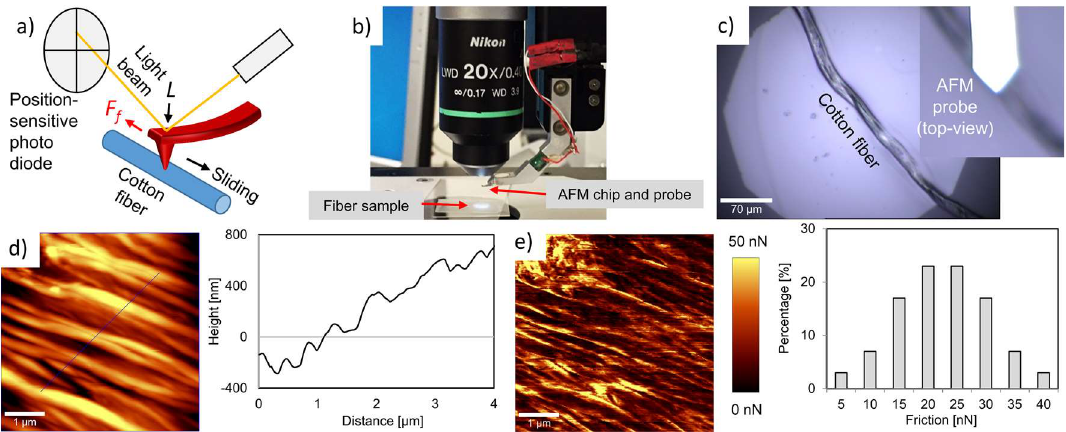
Figure 5. ( a ) Schematic of an atomic force microscope (AFM) probe as it raster scans the fiber surface; ( b ) AFM chip mounted on AFM head which is coupled with optical microscope system; ( c ) cotton fiber and AFM cantilever viewed from optical microscope; ( d ) typical topography image of cotton fiber surface. The plot show profile of fiber surface along the line; ( e ) corresponding friction image of the fiber surface. Plot shows the distribution of friction force.